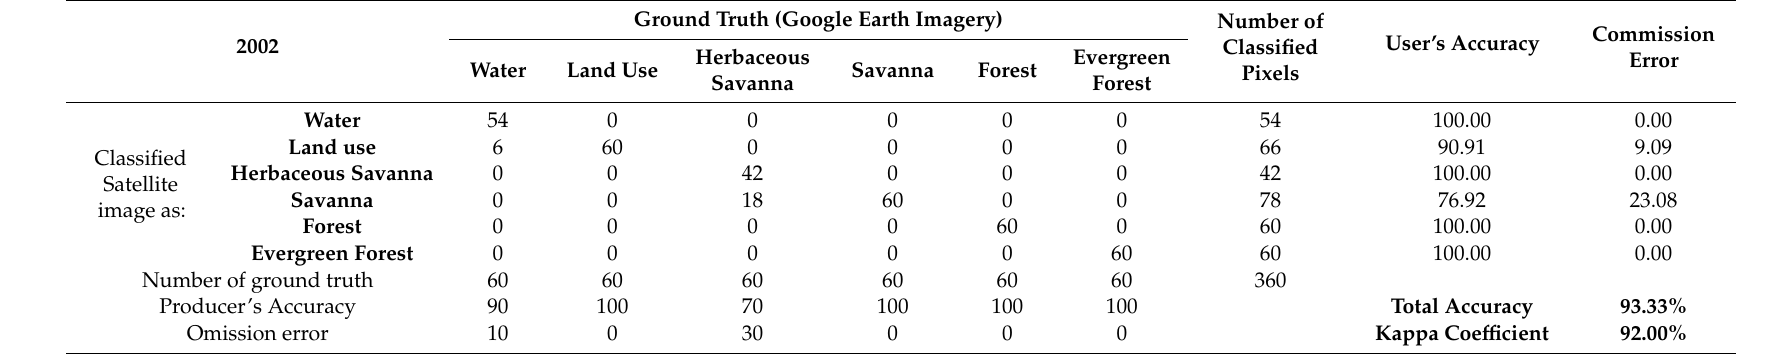
Table A2. Confusion matrix of the land use / cover classification for 2002